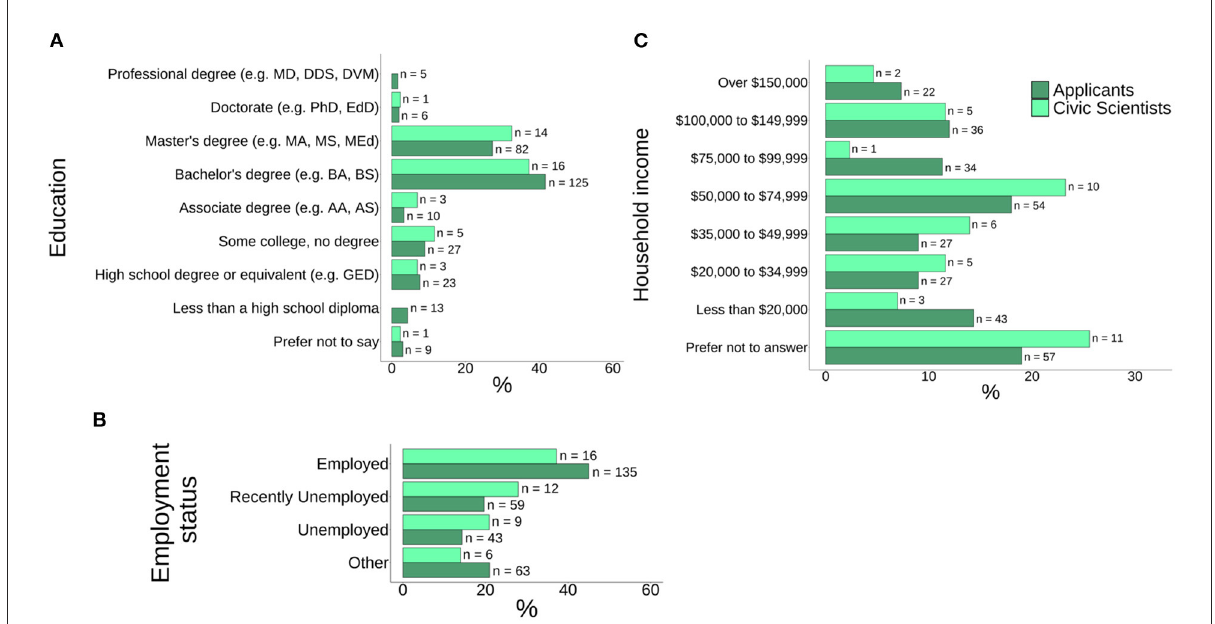
FIGURE1 Comparison of applicants and civic scientists: (A) education level, (B) employment status, and (C) household income. In (B) , “Other” refers to individuals who are either students or